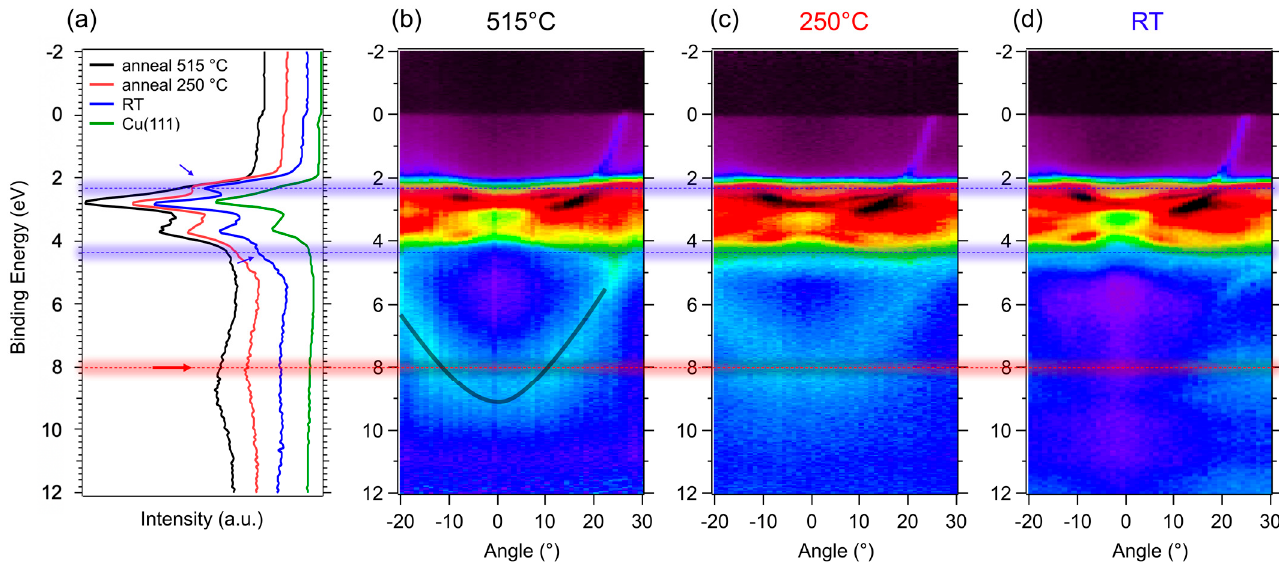
Figure 4. ( a ) UPS of BPBr 2 /Cu(111) after thermo treatment (RT, 250 ◦ C and 515 ◦ C) in comparison to the bare Cu(111) substrate. ( b – d ) ARUPS map of the corresponding samples. The blue arrows and dashed lines point to features related to the BPBr 2 intermediate products as they were not visible on bare Cu(111), nor on the 515 ◦ C sample. The red arrow and dashed line point to a new band dispersion after C–C bonding (250 ◦ C). This new state stayed and became ever stronger after the de-brominating process (515 ◦